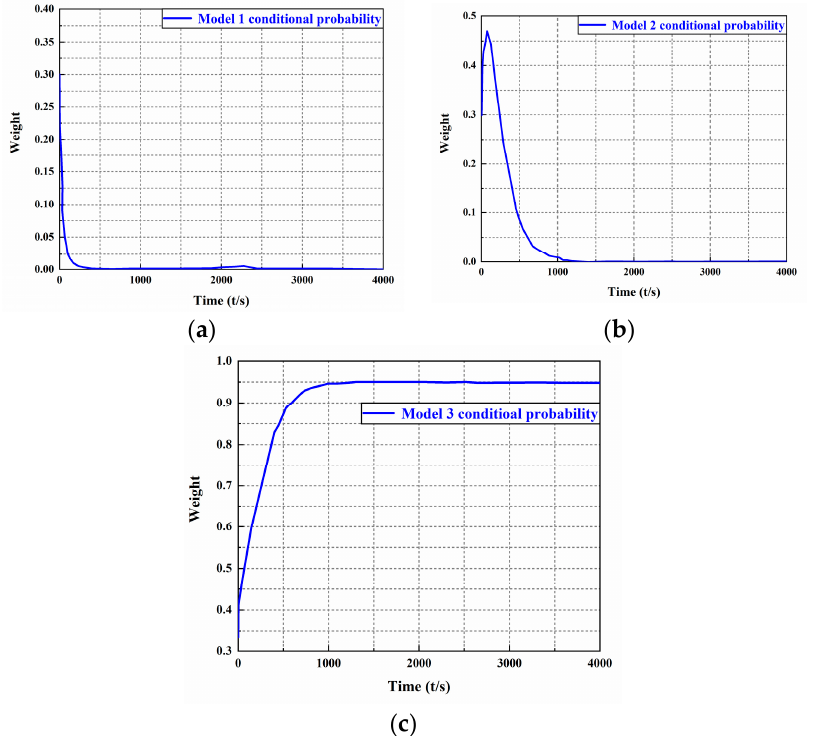
Figure 12. Weights curve of different battery models. ( a ) Weight curve of battery Model 1. ( b ) Weight curve of battery Model 2. ( c ) Weight curve of battery Model 3.